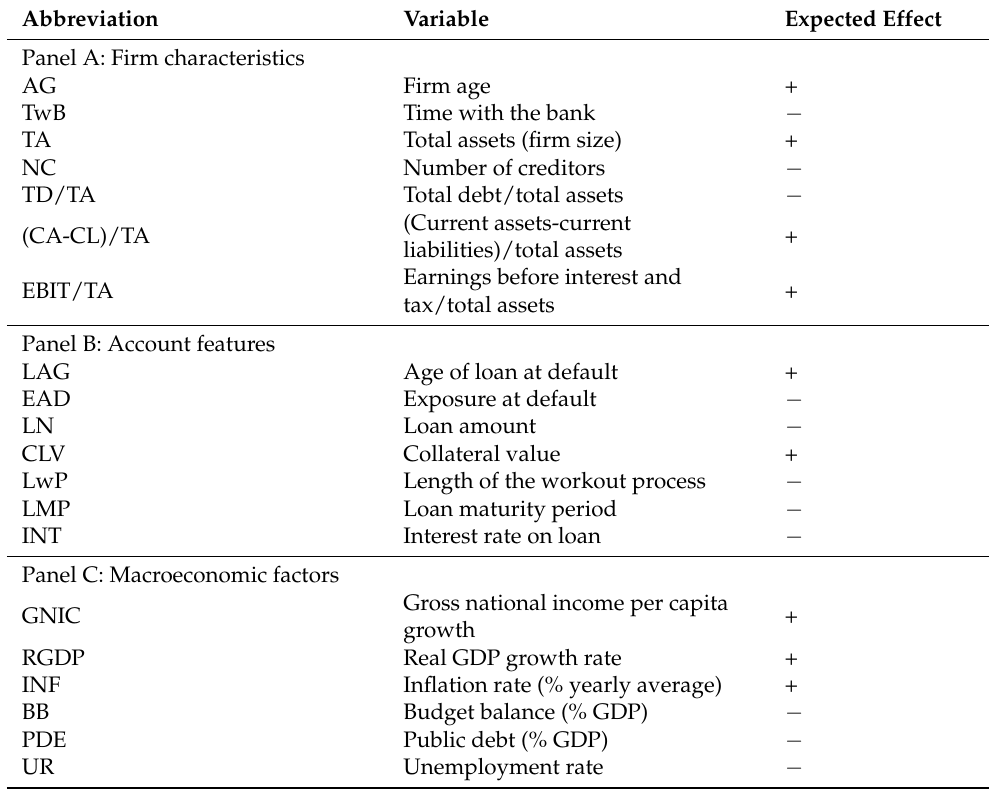
Table 1. Firm characteristics, account features and macroeconomic